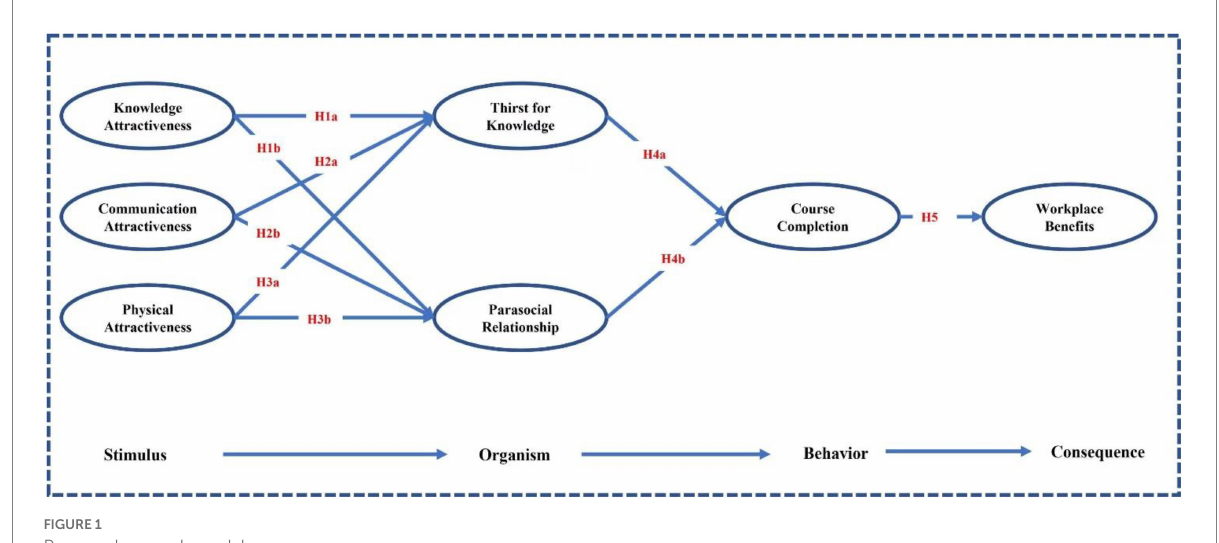
FIGURE 1 Proposed research